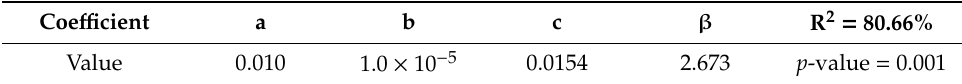
Table 5. Regression parameters of Equation (5) for the Circular Traveling Task (CTT). (SD(x) = [cm]; Speed [mm / s]; ID [bit]).